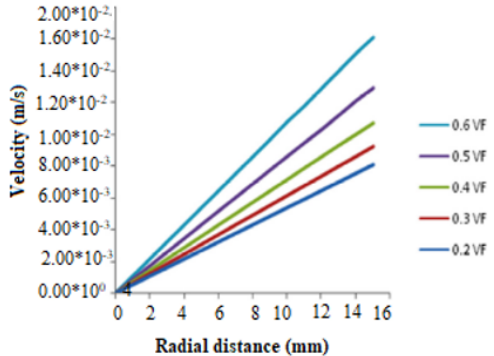
Figure 47. Impact of volume fraction in horizontal velocity [247].